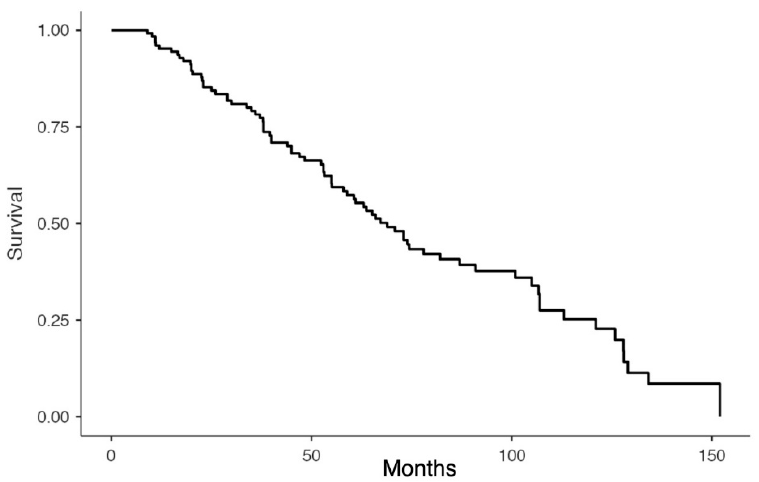
Figure 2. Overall survival after primary pancreatic resection.